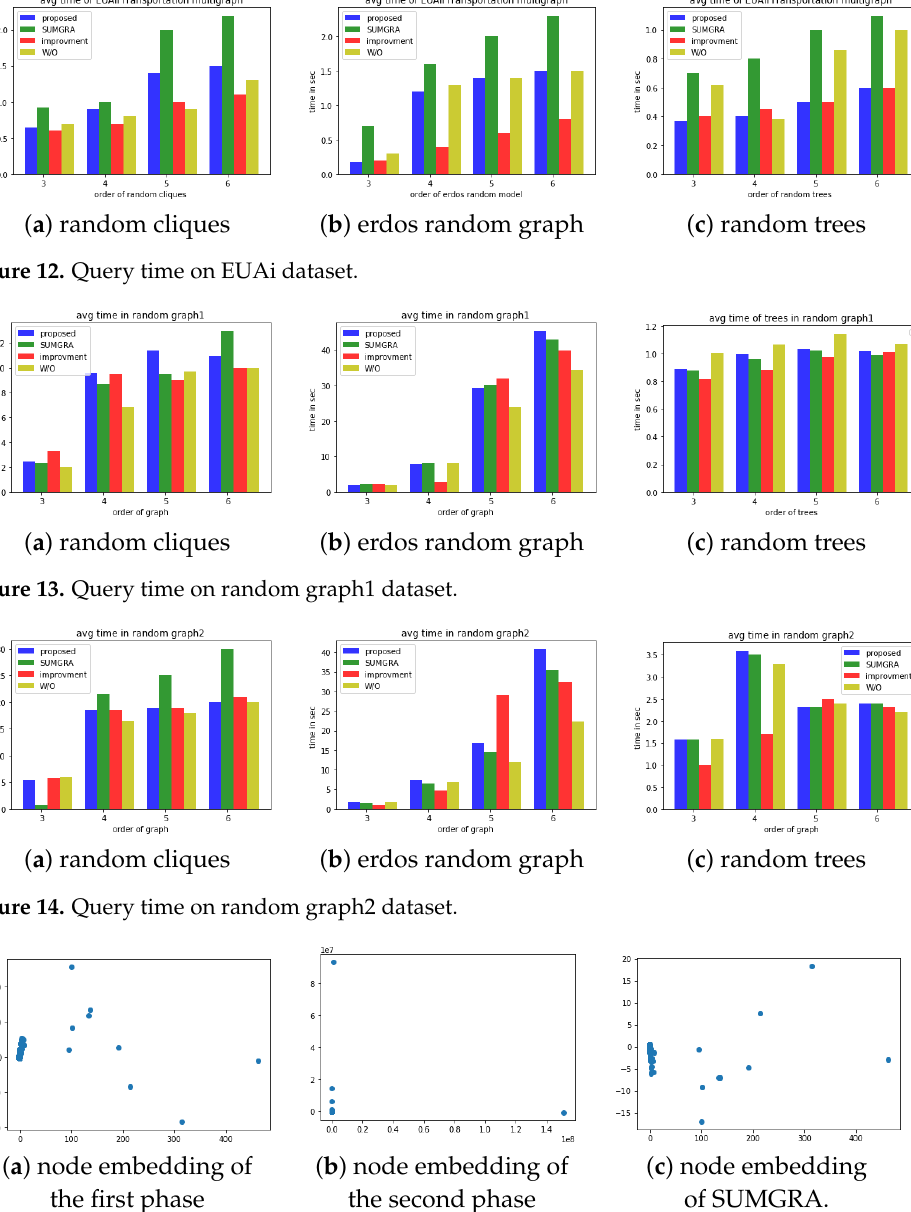
Figure 15. Node embedding of Human HIV4 dataset: ( a ) node embedding of the first phase of the proposed, ( b ) node embedding of the second phase of the proposed with/without meta-features, and ( c ) node embedding of the